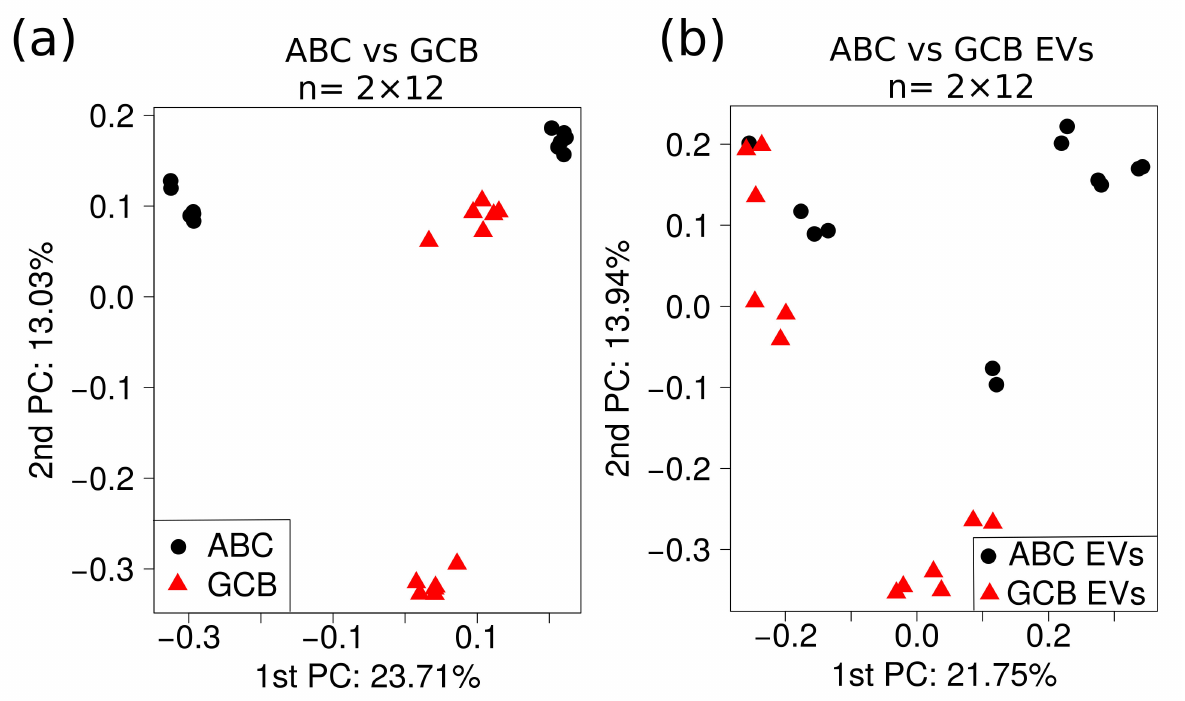
Figure A2. Principal component analysis of all quantitative data from whole cells ( a ) and EVs ( b